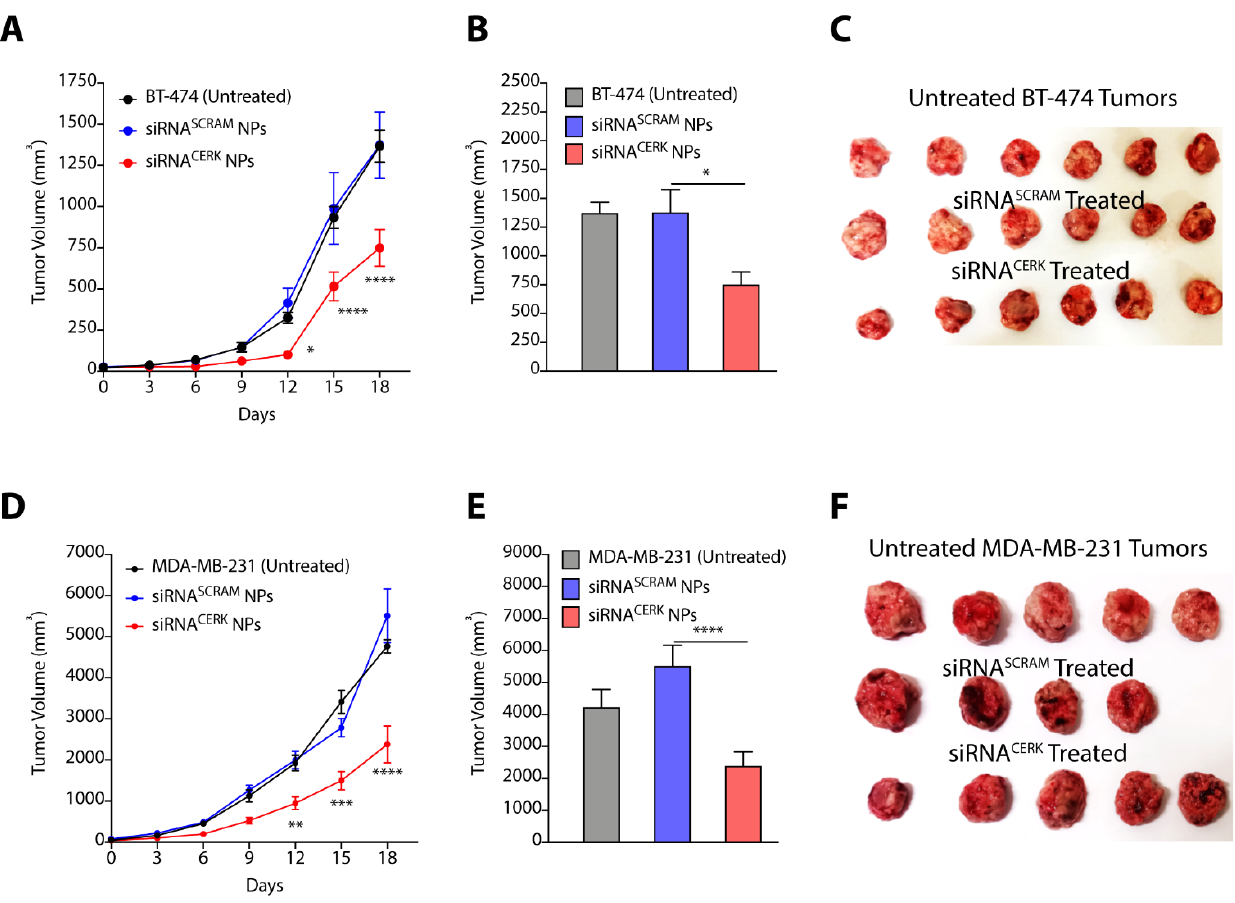
Figure 7. ( A – C ) Tumor growth kinetics ( A ), final day tumor volume ( B ), and pictures of excised tumors ( C ) showing the effect of siRNA CERK NPs targeting CERK in BT-474 tumors. ( D – F ) Tumor growth kinetics ( D ), final day tumor volume ( E ), and pictures of excised tumors ( F ) showing the effect of siRNA CERK NPs targeting CERK in MDA-MB-231 tumors. Data are presented as mean ± SEM ( n = 4–6), and were analyzed using two-way ANOVA for ( A , D ), and using unpaired student’s t -test for ( B , E ). * p < 0.05, ** p < 0.01, *** p < 0.001, **** p <